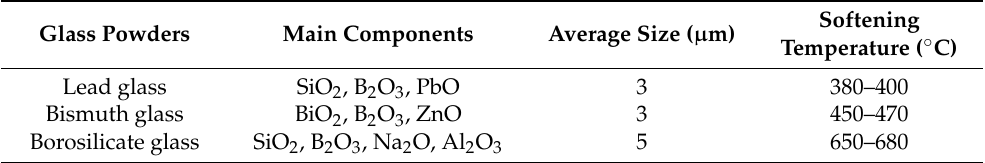
Figure 1. Preparation process of the glass coating on C/C substrate. Table 1. The basic characteristics of glass